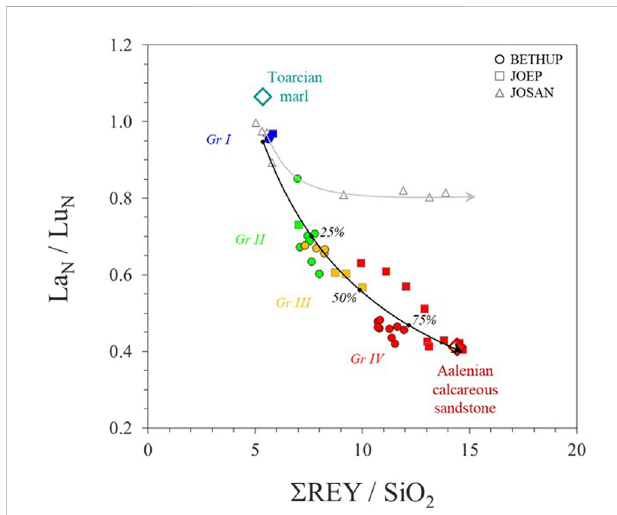
FIGURE 9 Relationship between the sum of REY concentrations normalized by SiO 2 concentration and the PAAS-normalized La N /Lu N ratio for the riverbed sediment samples, the Toarcian marl and the Aalenian calcareous sandstone collected in the Orne River basin. Also are indicatedonthemixinglinethecontribution,in%,oftheindustrialwaste in the bulk core sediment samples. The color refers to the group of REY de fi ned in Figure